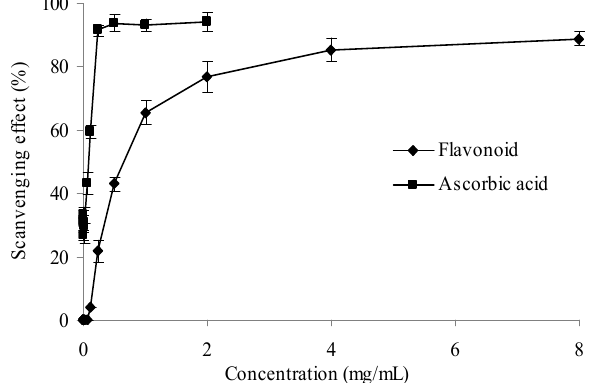
Figure 6. Hydroxyl radical scavenging activities of sample and control standards, Each value is expressed as a mean ± S.D (n =